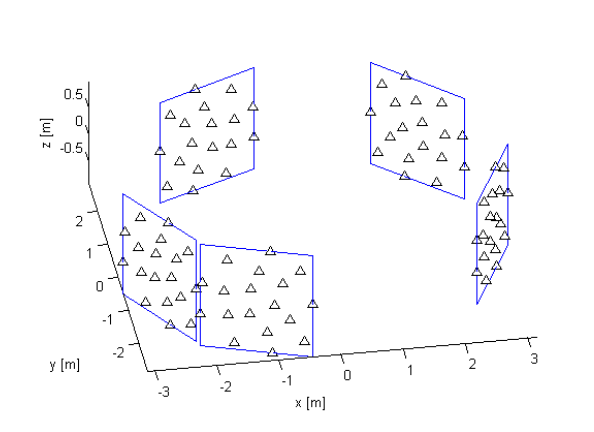
Figure 13. The Rx array geometry G 90 .